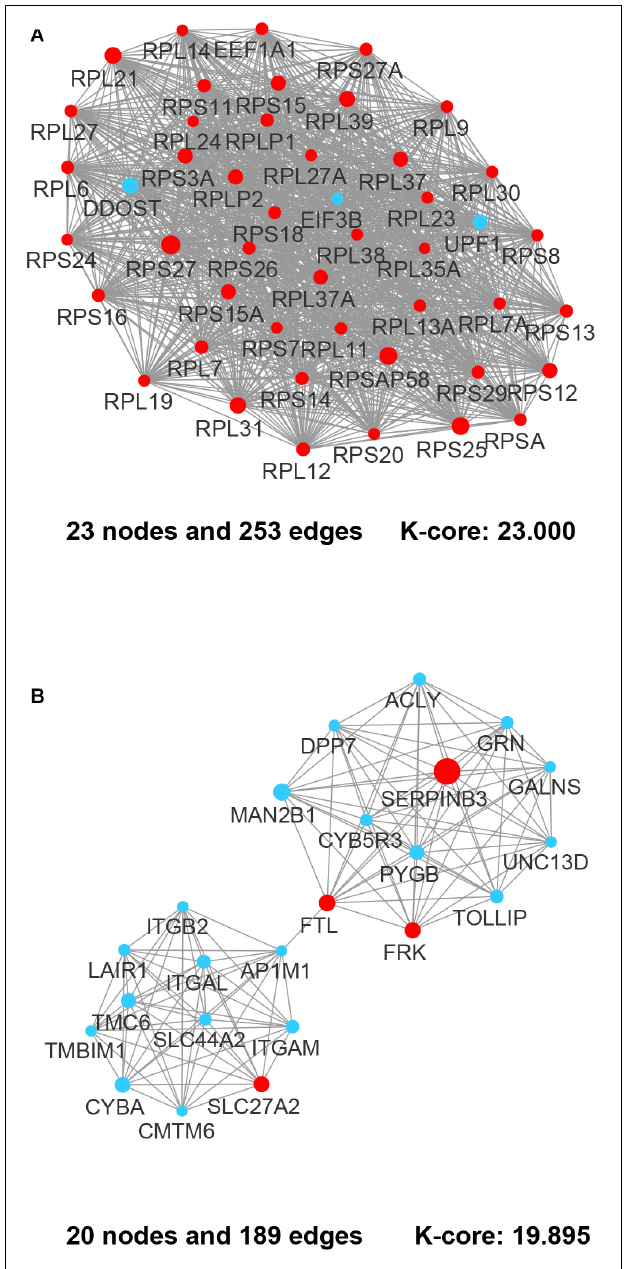
FIGURE 4 | The most prominent modules of the DEGs PPI network. The nodes representing up-regulated DEGs are shown as red circles and the down-regulated DEGs are presented as blue circles. The sizes of the nodes are illustrated from small to big in ascending order of |Log2 (FC)|. (A) Cluster 1. (B) Cluster